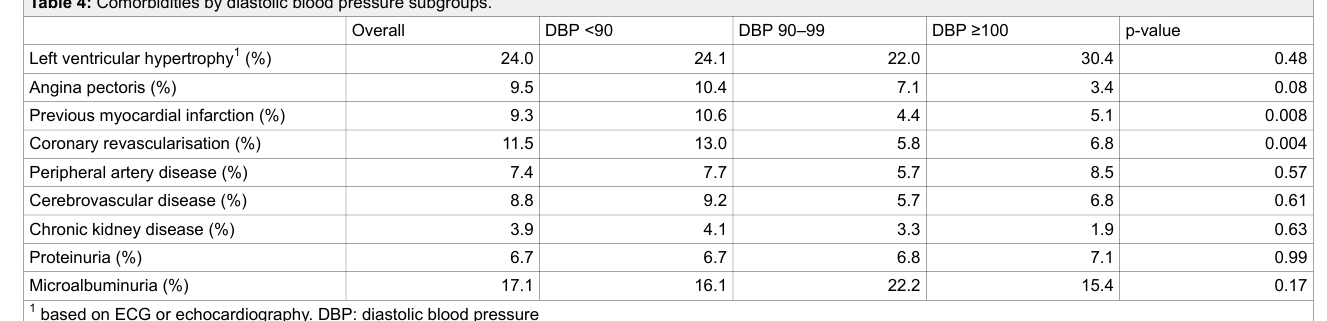
Table 4: Comorbidities by diastolic blood pressure subgroups.